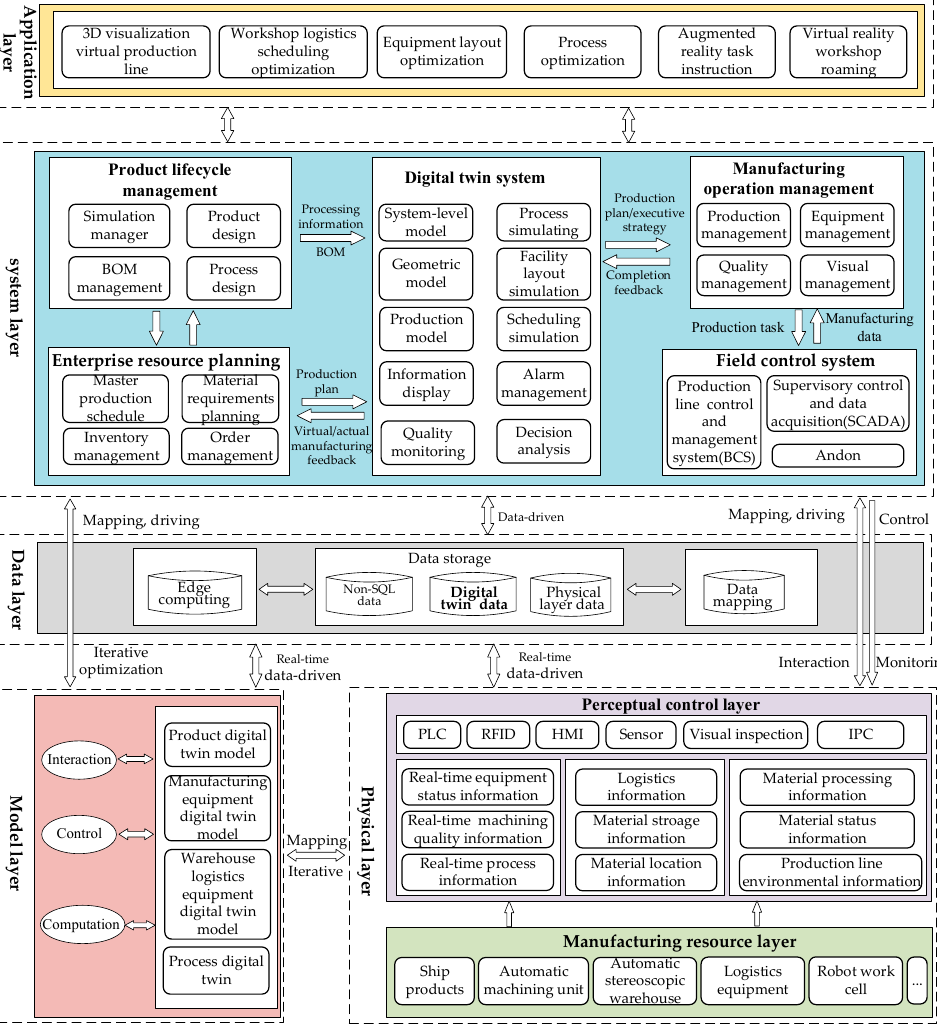
Figure 1. Application framework of digital twin-driven ship intelligent manufacturing system.